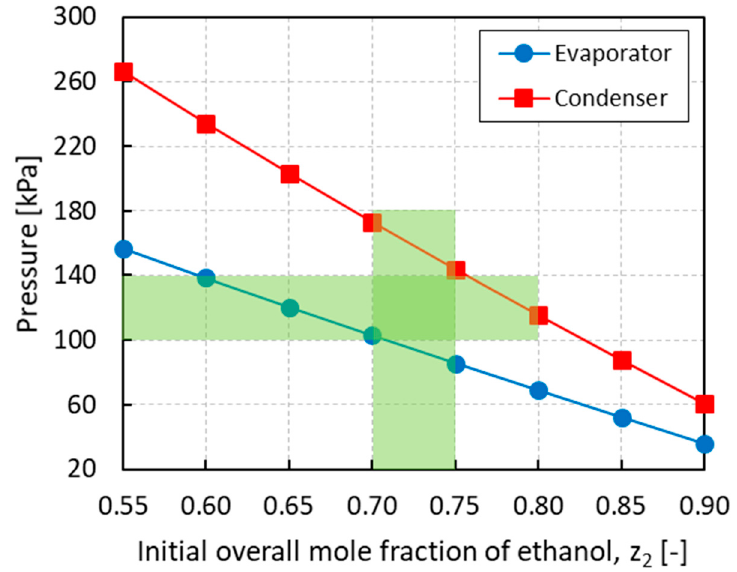
Figure 6. Pressure in the evaporator and condenser vs. the initial overall mole fraction of ethanol z 2 . The intersected shaded area identifies the optimal operating window.